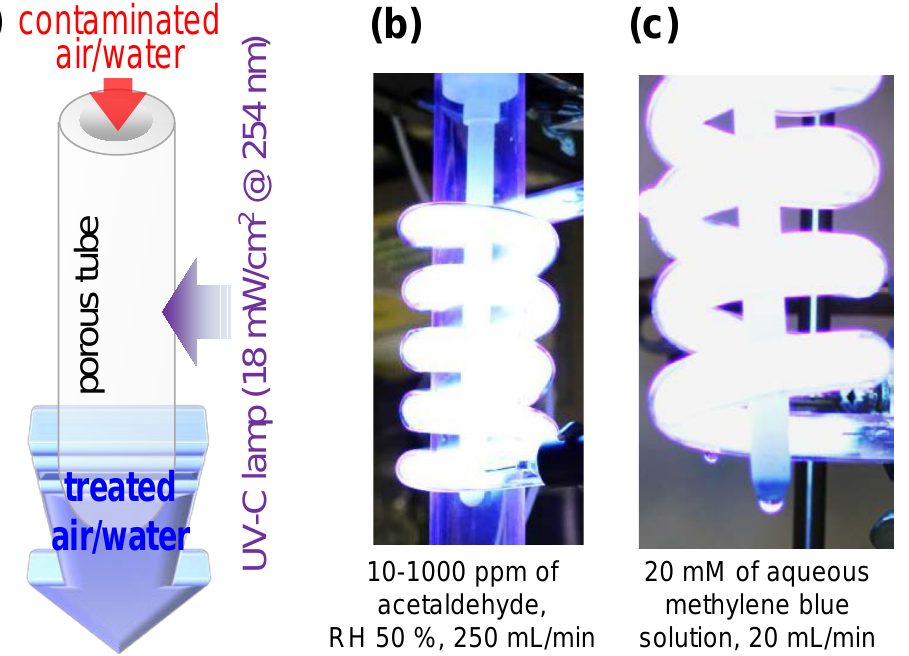
Figure 8. Schematic ( a ) and photographs of the air- ( b ) and water- ( c ) purification test for the TiO 2 -impregnated a-silica